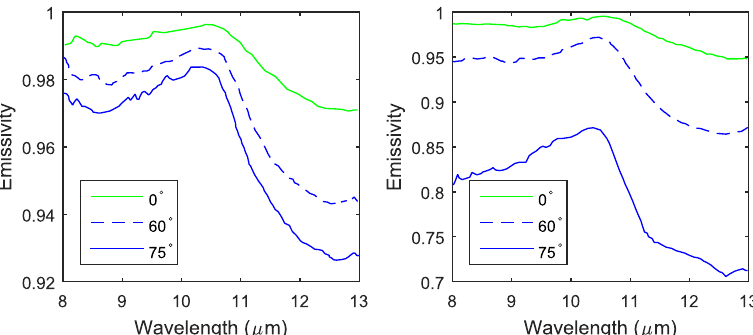
Fig. 5. Large contrast via different vertical axis ranges, between bare smooth ice (right) and course granular snow (left) in angular variations, from normal exit (top curve) to 75 ° exit (bottom curve) for spectral emissivity from 8 m m to 12.5 m m. The “ free ” total emissivity curve lies closer to higher exit angle curves (plots adapted from select data within Fig. 3 of Ref. [8]).